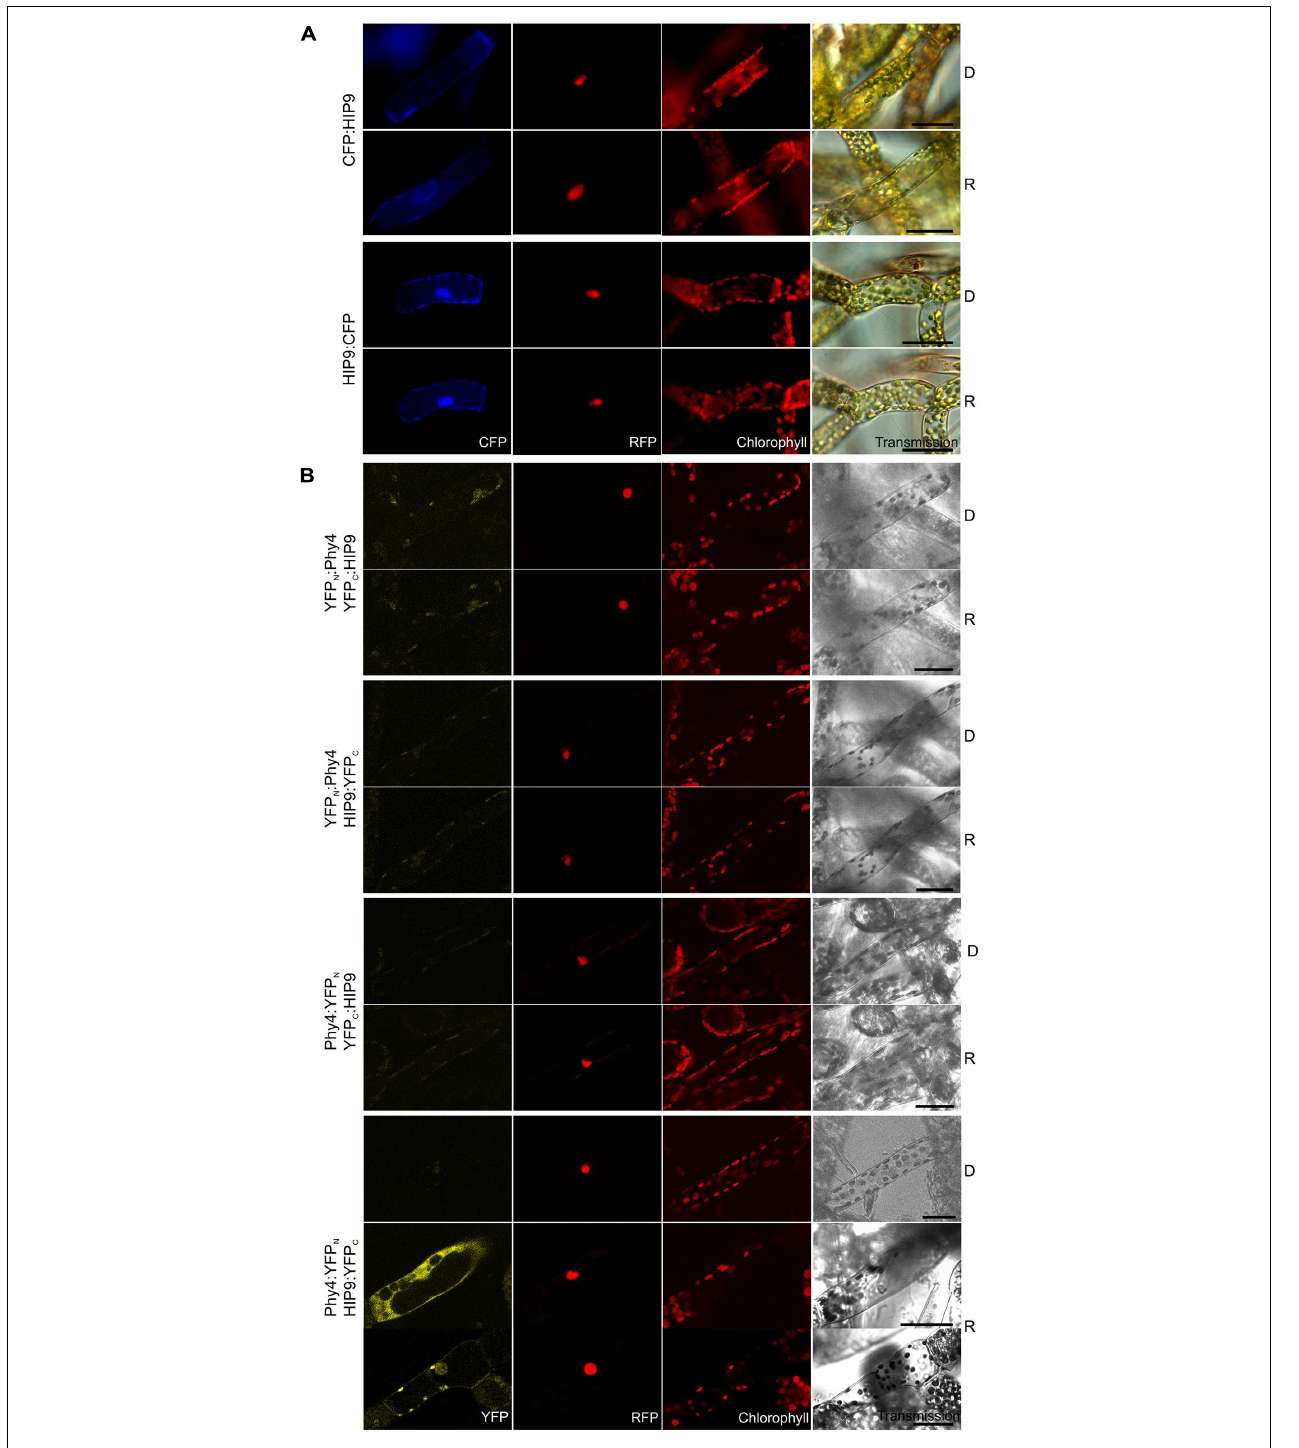
FIGURE 8 | HIP9 (Pp1s254_10V6.2) intracellular localization (A) and split-YFP-studies of HIP9–phy4 interaction (B) each without (D) and with R pre-treatment (R) using fluorescence- and confocal microscopy, respectively. Overall figure structure is analogous to Figure 1 . (A) CFP:HIP9- (rows 1 and 2) and HIP9:CFP-fluorescence (rows 3 and 4) was observed in the cytoplasm or the nucleus and cytoplasm, respectively (column 1, CFP). (B) All possible split-YFP configurations were investigated: YFP N :phy4–YFP C :HIP9 (rows 1 and 2), YFP N :phy4–HIP9:YFP C (rows 3 and 4), phy4:YFP N –YFP C :HIP9 (rows 5 and 6) and phy4:YFP N –HIP9:YFP C (rows 7–9; two distinct patterns in R). However, two different signal patterns (nucleus and cytoplasm or perhaps nucleus and plasma membrane) were only observed for phy4:YFP N –HIP9:YFP C after R pre-treatment (column 1, YFP; D and R images here from separate experiments). Scale bars 30 µ